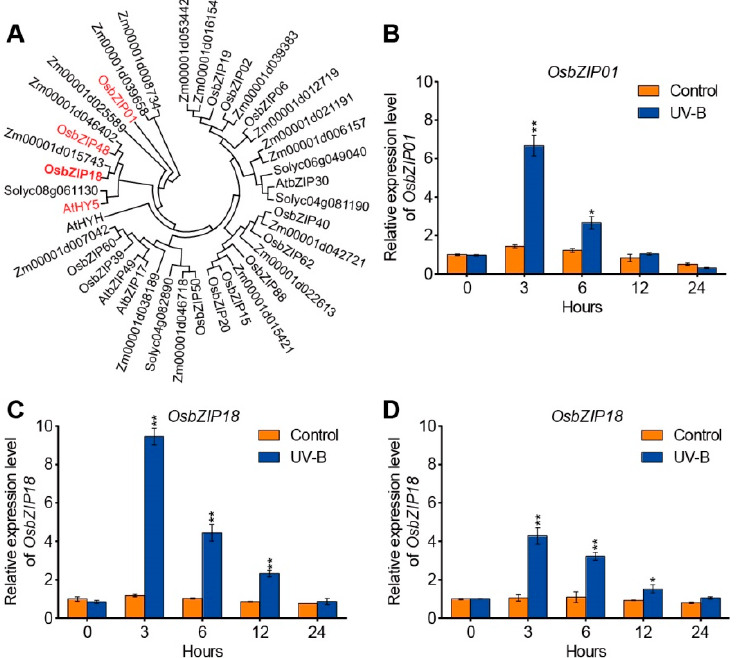
Figure 2. Effect of UV-B radiation on the transcript levels of rice HY5 genes. ( A ) The phylogenetic tree of HY5 protein in Arabidopsis , rice, maize, and tomato. The values of bootstraps from 1000 replicates are indicated. ( B – D ) Expression analysis of OsbZIP01 ( B ), OsbZIP18 ( C ), and OsbZIP48 ( D ) under control and UV-B radiation. The relative expression levels were normalized to those of ubiquitin and were quantified by RT-qPCR. Two-week-old seedlings were subjected to UV-B for 0, 3, 6, 12, and 24 h. Os, Oryza sativa ; At, Arabidopsis thaliana ; Zm, Zea mays ; Solyc, Solanum lycopersicum . The data are means ± SD of three biological replicates. Asterisks indicate a significant difference between the control and UV-B treatments at individual time points (* p < 0.05 and ** p < 0.01, Student’s t -test).